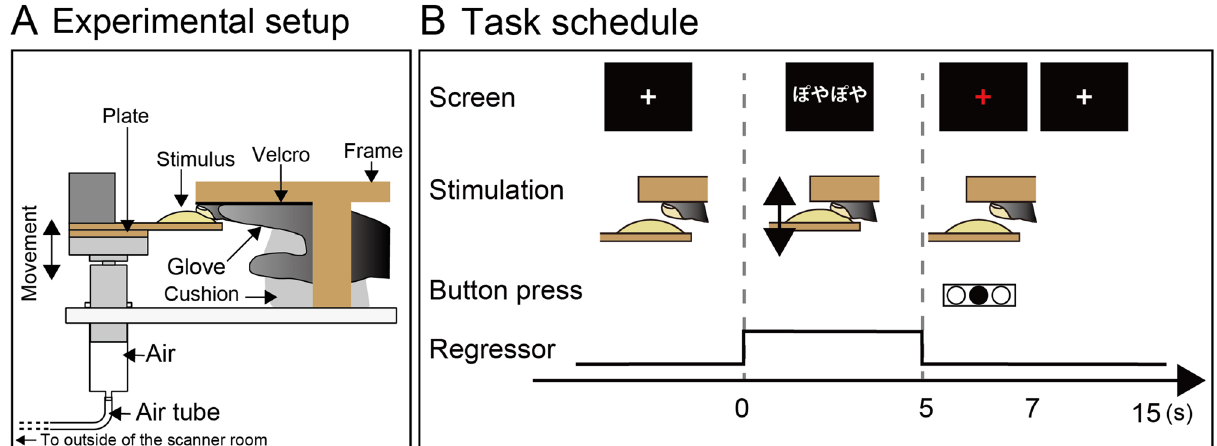
Figure 1. Experimental design. ( A ) Setup. We used an apparatus consisting of two cylinders that are connected via an air tube. A weight that was placed on the cylinder outside the scanner (not shown in the figure) pushes the cylinder inside the scanner via the air tube, which moved the stimulus onto the subject’s middle finger. The tactile stimuli had identical shapes and sizes, whereas their compliances, deformation per applied force, were varied. ( B ) Task schedule. In each trial, the fixation cross was replaced with one of the sound symbolic words, and the tactile stimulus was pushed onto the finger twice within 5 s. The subject was asked to judge the congruency of softness/hardness between tactile stimulus and sound symbolic words by pressing a button when the red fixation cross was presented. In the control condition in which randomized characters were presented and no tactile stimulus was given, the subject was asked not to respond.